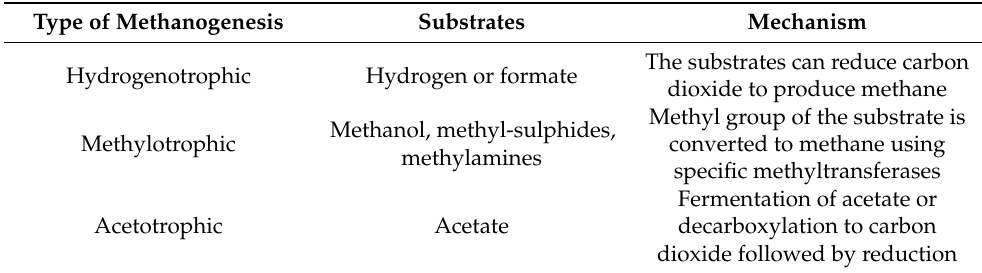
Table 3. Methods of methanogenesis by different methanogens. Type of